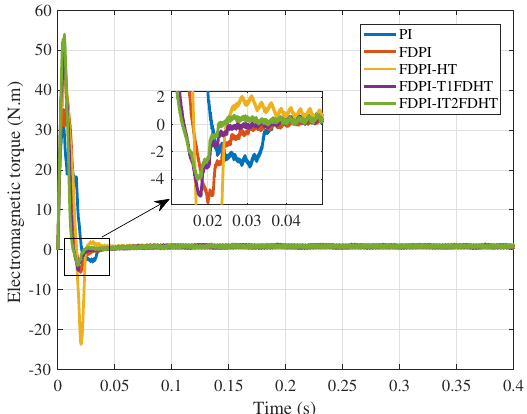
Figure 13. Electromagnetic torque response results in the no-load case.